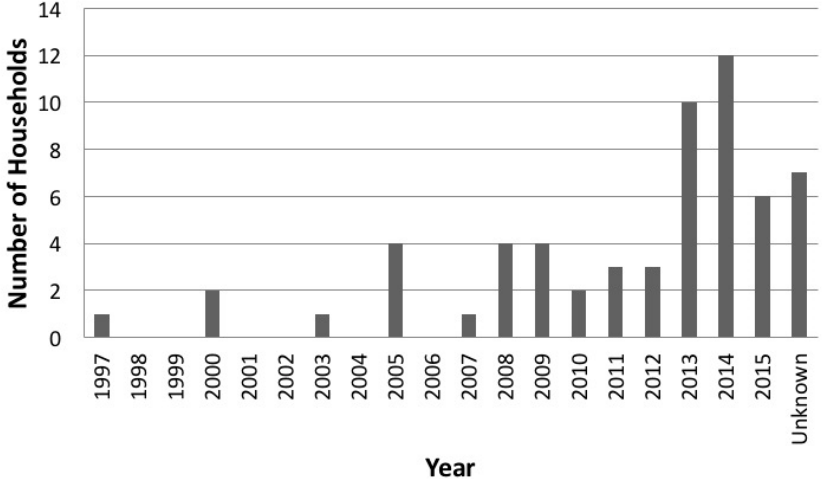
Figure 2. Number of households that installed DF toilets, by year of installation.